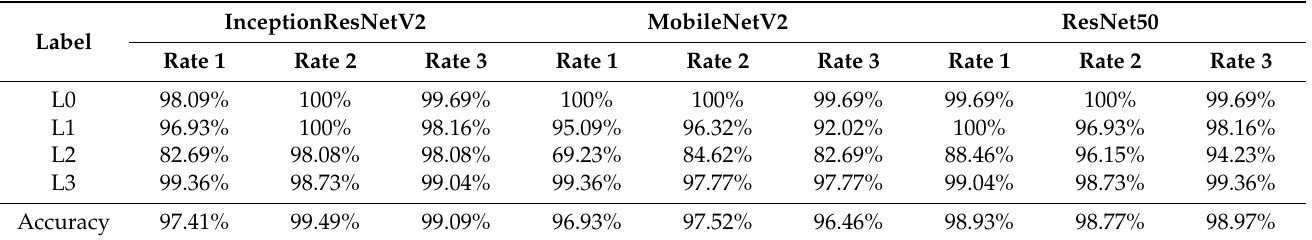
Table 6. Classification results of transfer learning based on InceptionResNetV2, MobileNetV2, and ResNet50.